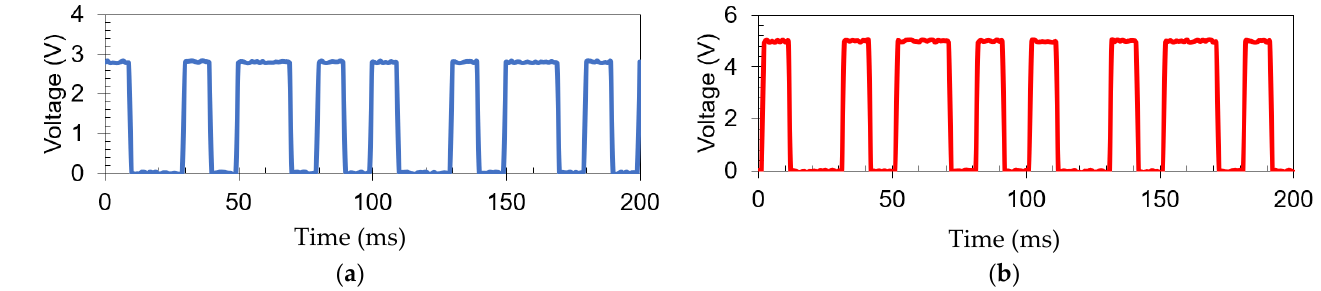
Figure 19. Transmit ( a ) and receive ( b ) data signal at 100 bps using a 2 kHz